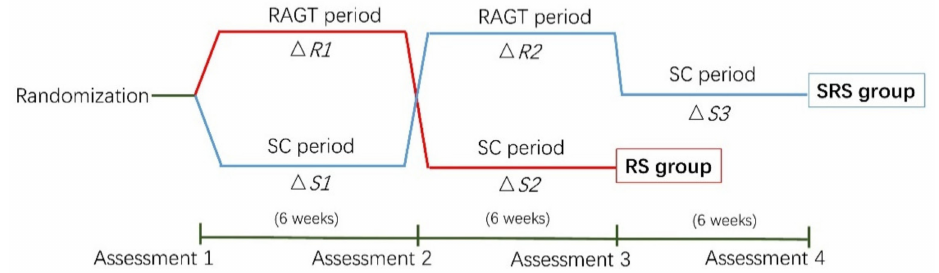
Figure 3. Statistical analyses. Abbreviations: RS, robot-assisted gait training / standard care sequence group; SRS, standard care / robot-assisted gait training / standard care sequence group. RAGT, robot-assisted gait training; SC, standard care; (cid:52) R1, delta value during robot-assisted gait training in the RS group; (cid:52) R2, delta value during robot-assisted gait training in the SRS group; (cid:52) S1, delta